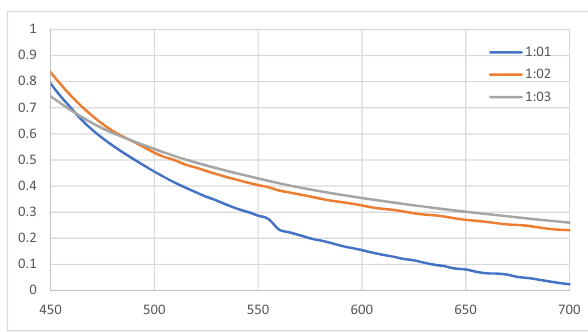
Figure 2: UV spectra of AgNPs solution with the aqueous extract of Tropaeolum majus .